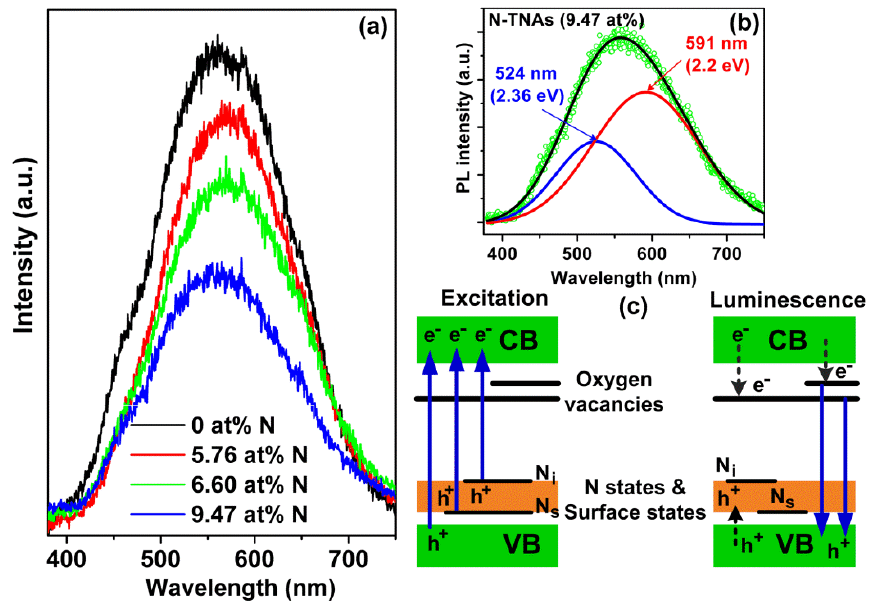
Figure 5. ( a ) Photoluminescence spectra of TNAs and N-TNAs with different N concentrations from 5.76 to 9.47 at %. ( b ) The fitting PL spectrum for the N-TNAs (9.47 at %), two peaks can clearly be observed. ( c ) Energy level model for excitation and luminescence processes in N-TNAs.